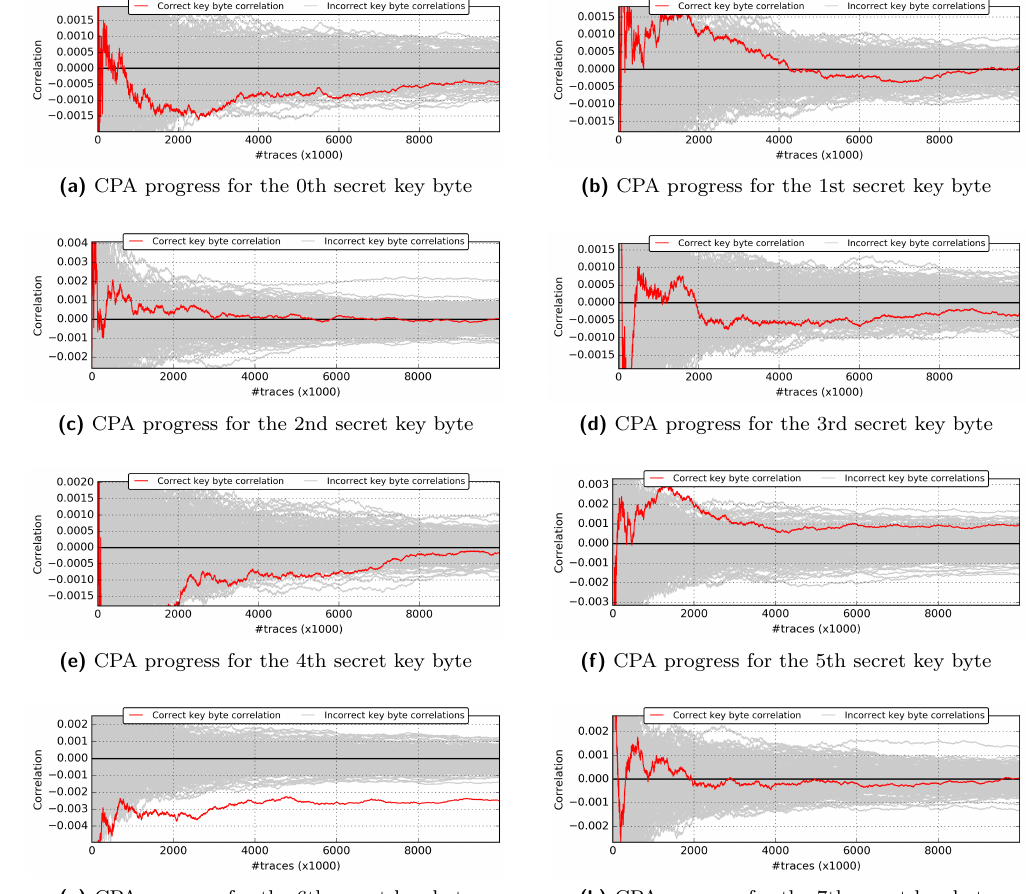
Figure 21: Results of a CPA attack on the last secret round key (bytes 0 to 7) of AES on the STM32F407VG Discovery #1 @168MHz with the ADC connected to GND and the program compiled with the -Os optimization option. Each plot shows the correlation progress of all 256 key candidates for a specific key byte over 10 M traces and the respective correct key candidate is marked